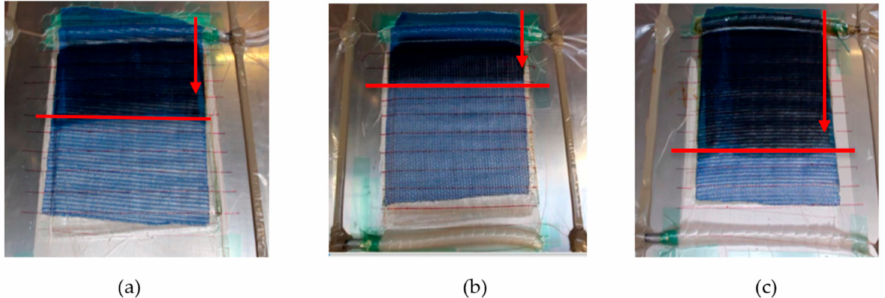
Figure 3. Experimental photograph of resin flow during ( a ) B-flax, ( b ) E-flax and ( c ) P-flax composite manufacturing. The red line marks the flow front position at two minutes fill time.